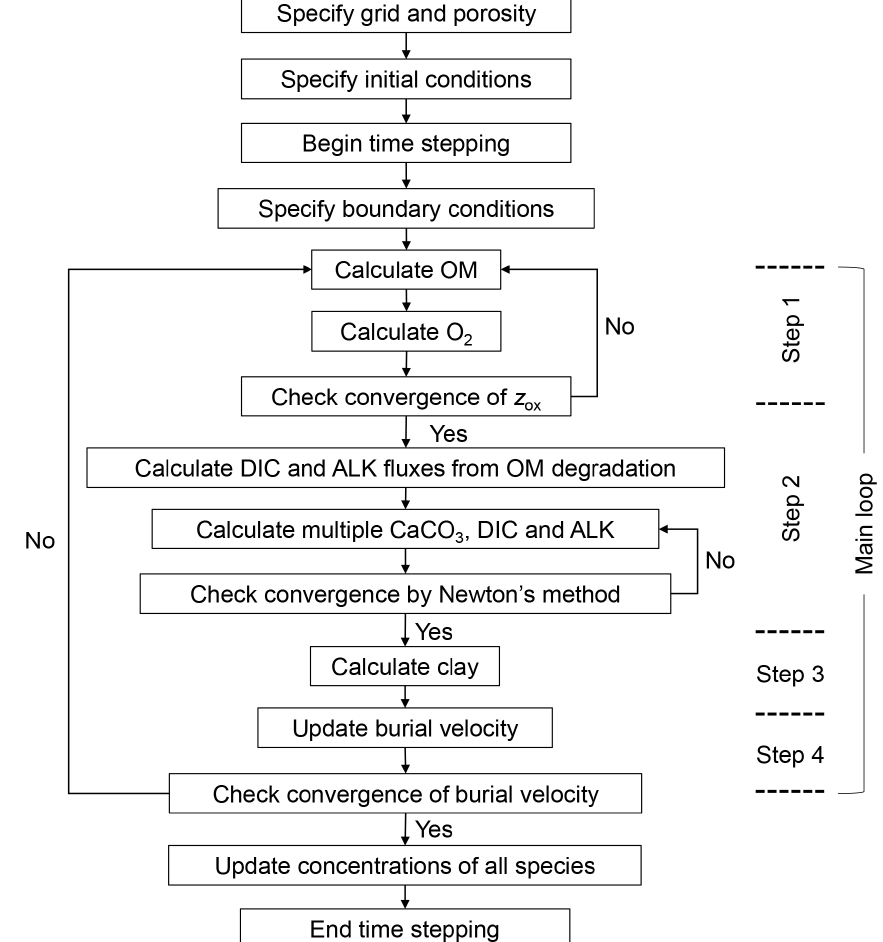
Figure 2. Program structure for reactive-transport modeling of